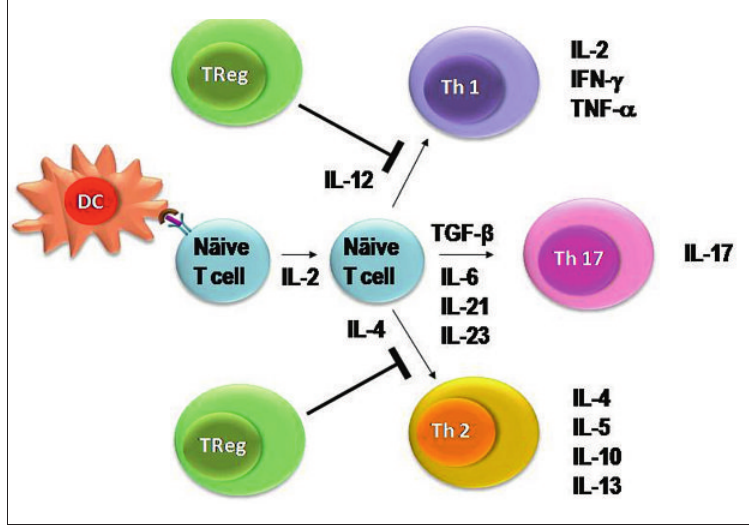
NäiveT cell differentiation intoTh1,Th2, orTh17 cells and cytokine prevalently produced by these cells. The presence of interleukin (IL) 12 drivesTh1 differentiation; IL-4 induces theTh2 phenotype, whileTGF- b , IL-6, IL-21, and IL-23 stimulateTh17 differentiation. Regulatory T cells (TReg) inhibit IL-12 and IL-4-mediatedTh1 andTh2 differentiation. IL: Interleukin; IFN: Interferon;TNF:Tumour necrosis factor;TGF:Tumour growth factor; DC: Dendritic cell;Th:T helper